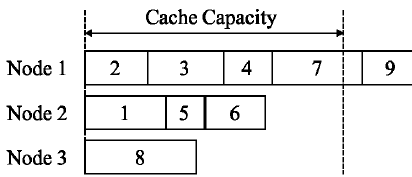
Figure 2. Data item allocation without considering node